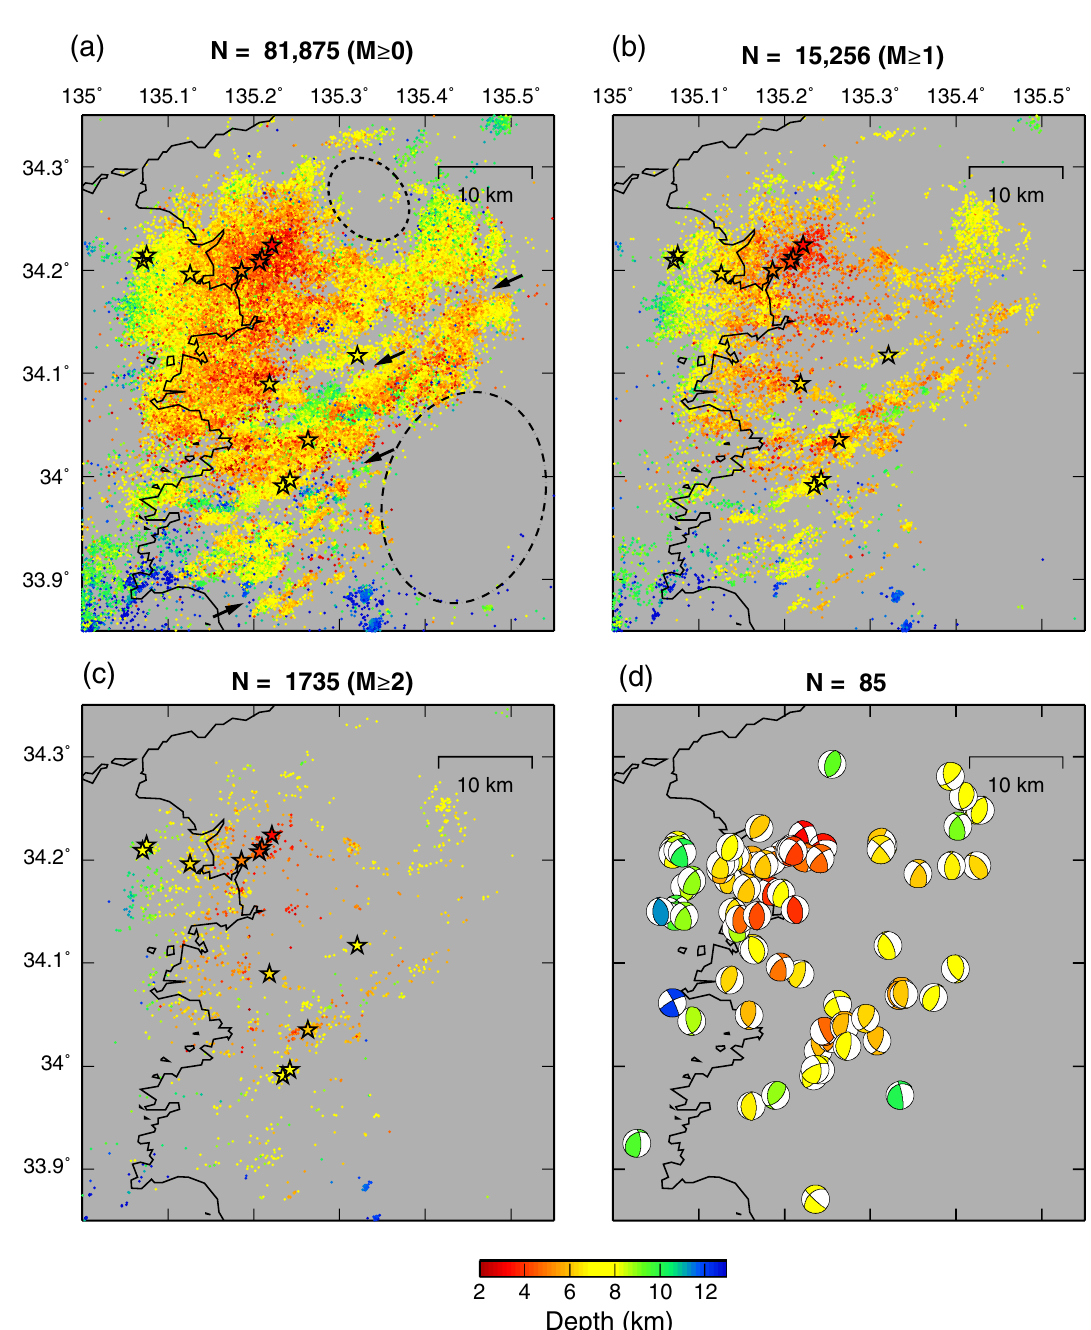
Fig. 4 Hypocenter distributions of the Wakayama swarm during the 2003–2020 period. a M earthquakes. Dashed ellipses and arrows in ( a ) denote areas and lineaments with limited seismicity, respectively. Stars in ( a – c ) denote M earthquakes. Focal depths are color-coded. d Focal mechanism solutions for the M